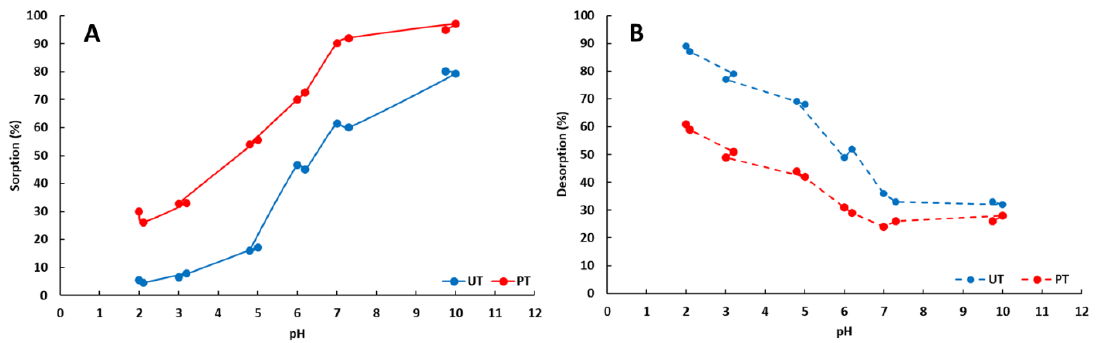
Figure 9. Effect of pH on ( A ) sorption and ( B ) desorption of copper ions on untreated and polymer- treated tailings.